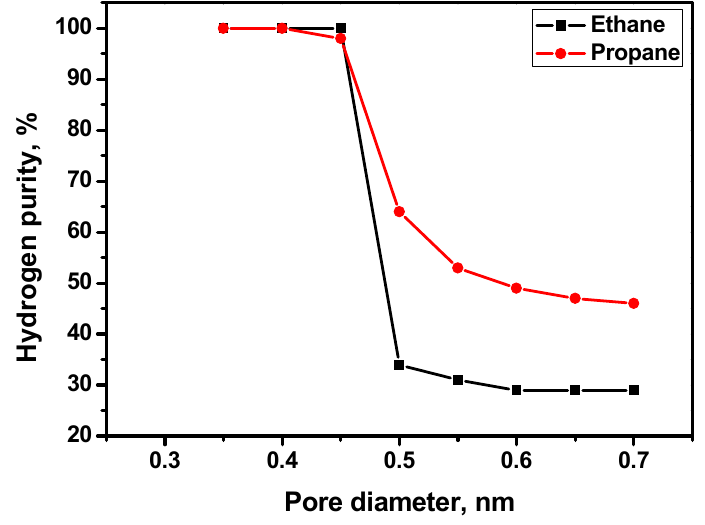
Figure 7. Hydrogen purity depending on the membrane pore diameter.